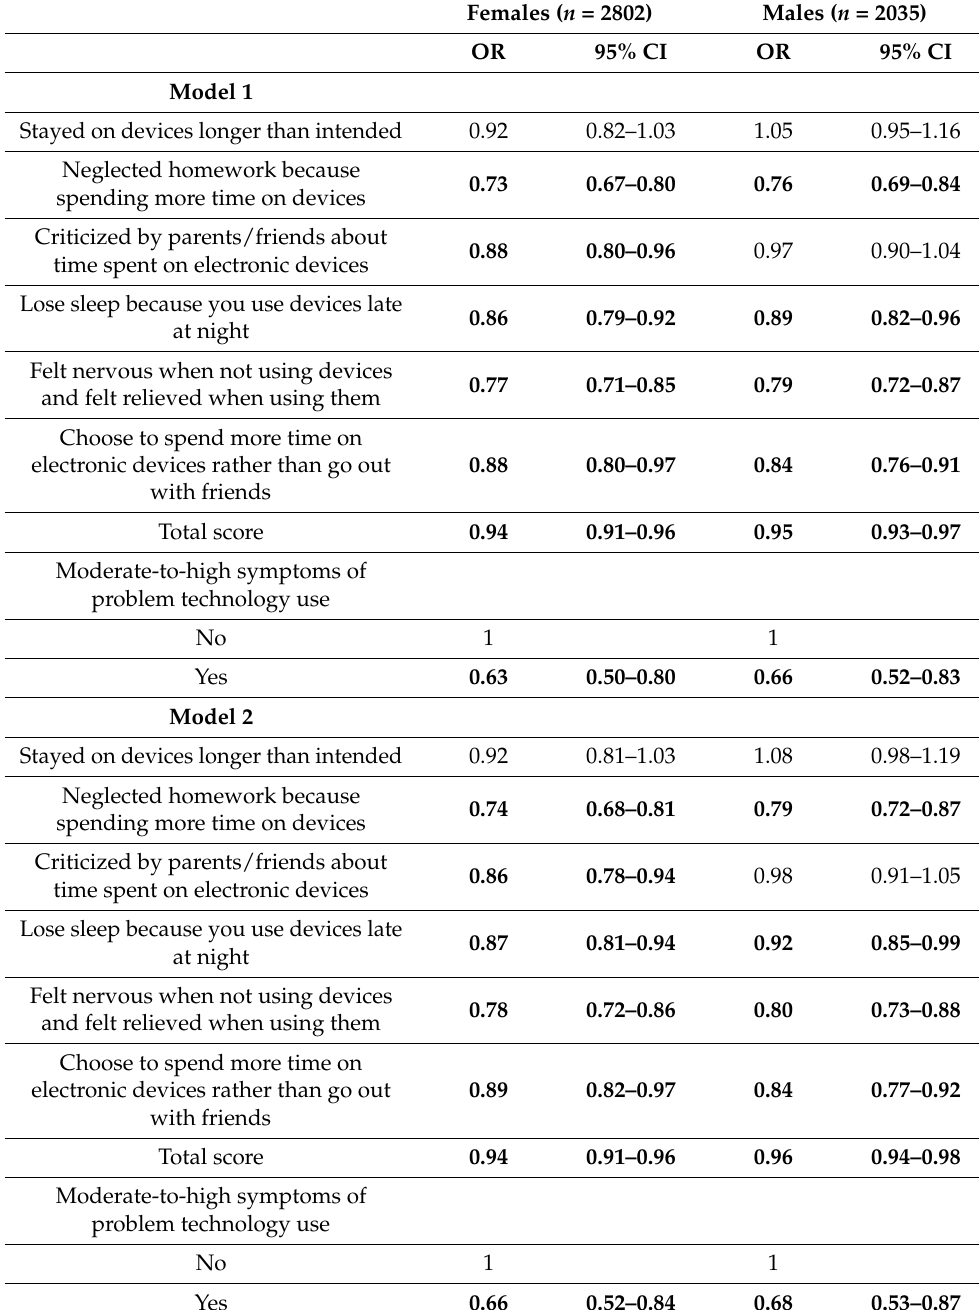
Table 3. Associations of moderate-to-high symptoms of problem technology use with academic performance among adolescent females and